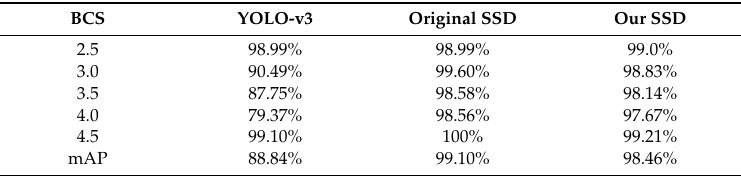
Table 4. Results of the classification accuracy (CA) for each BCS level.